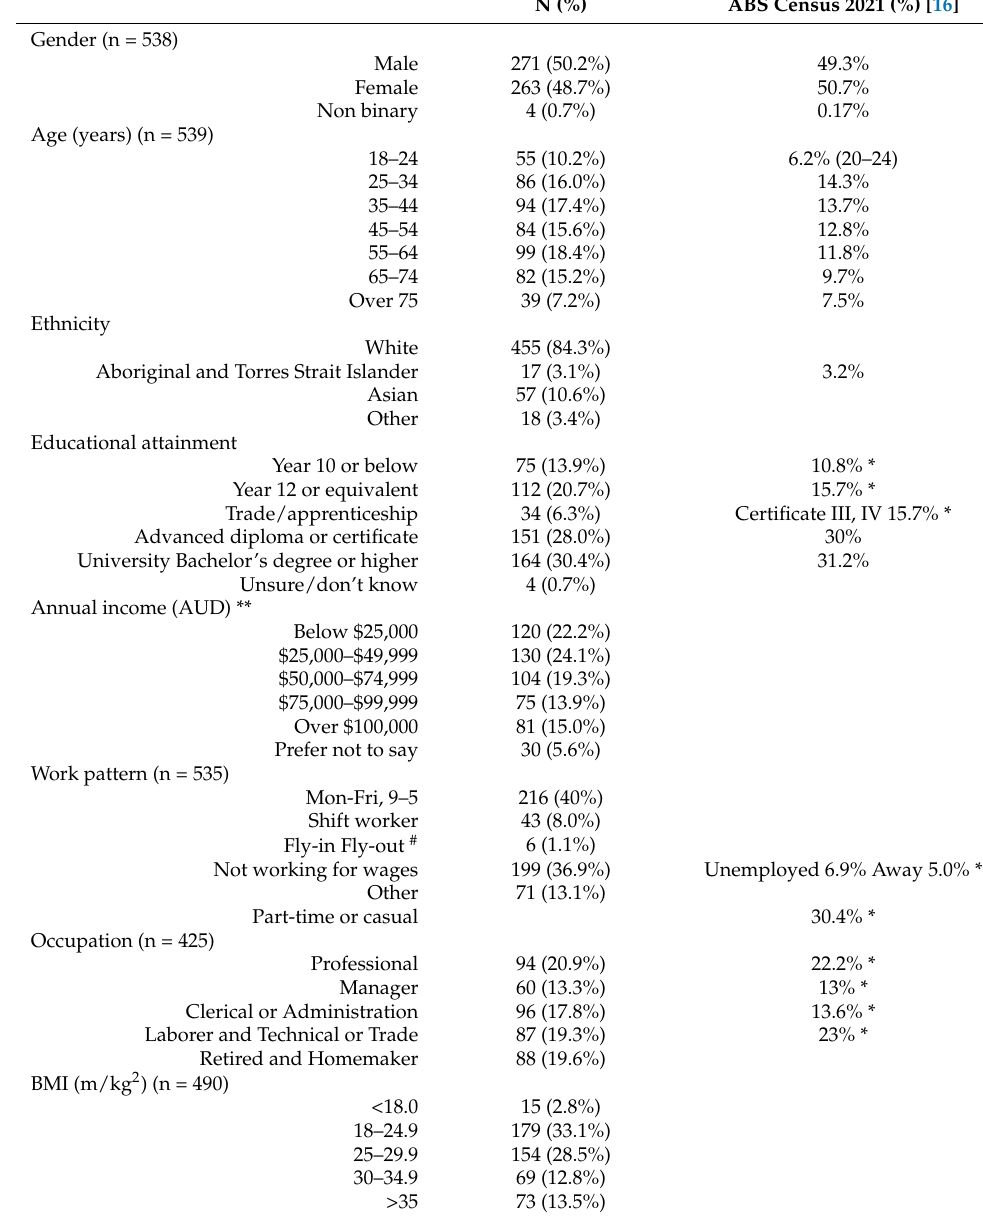
Table 2. Demographic characteristics of participants compared to the 2019b Australian census